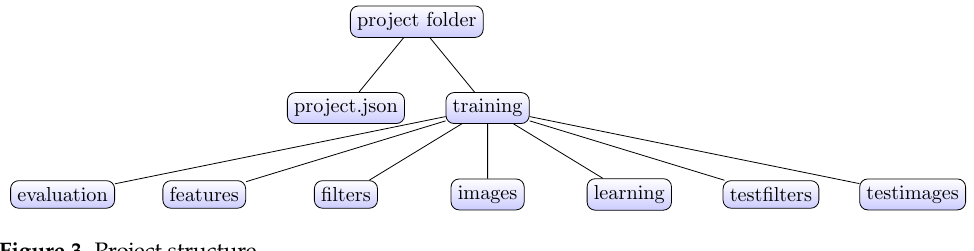
Figure 3. Project